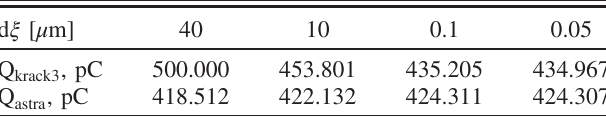
TABLE III. Numerical convergence study by varying the longitudinal mesh resolution (d ξ ) a .